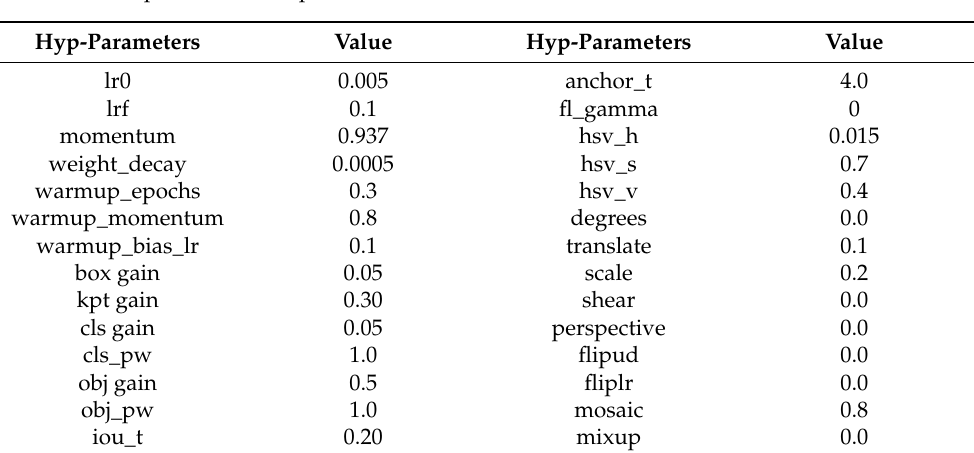
Table 4. Smart phone camera